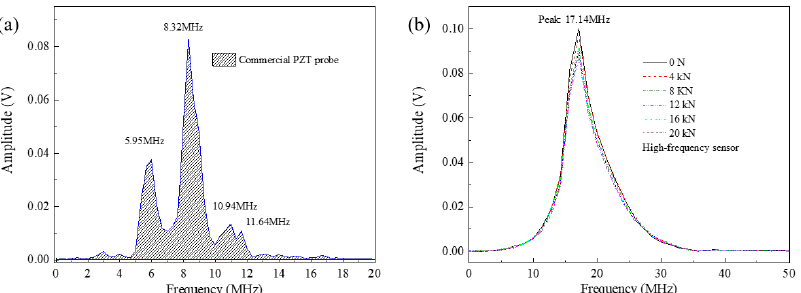
Figure 6. Frequency spectra of the measured ultrasonic wave collected from ( a ) the commercial PZT probe and ( b ) the high − frequency piezoelectric sensor.